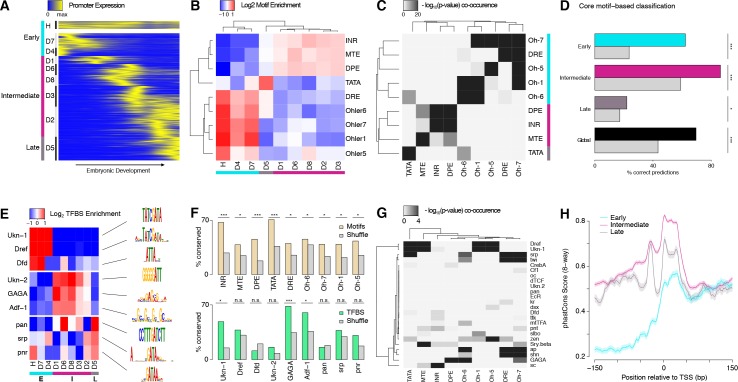
Core promoter structure defines three broad phases of embryonic development.(A) Clustering of expression profiles for 3462 promoters (maximum expression ≥10 RPM) defined as housekeeping (H, n = 240) or developmentally regulated (D, n = 3,222). Developmentally regulated promoters are divided into eight groups based on hierarchical clustering of expression profiles (see Materials and methods). Core promoter structure defines three broad developmental phases (color sidebar). (B) Relative enrichment of core promoter motifs in each expression cluster. Three major clusters can be defined (bottom color bar), which correspond to 3 phases of embryonic development (see (A); Early: 817 TSCs; Intermediate: 2,047; Late: 598). (C) Clustering of core promoter motifs based on their co-occurrence in the same promoters. This approach yields the same three major sets of motifs previously defined based on expression profiles (see (B)). (D) Predictions of expression timing from core promoter structure. Quadratic discriminant analysis on log-transformed motif scores was used to predict the developmental phase in which promoters are expressed. The performance of the classifier in leave-one-out cross-validation (color bars) is compared to random expectation (grey bars; FDR-corrected chi-square tests applied to individual contingency tables as appropriate). (E) Distinct sets of TFBSs are enriched near the core promoters active in the three developmental phases. The top three motifs for each core promoter class are shown. (F) The conservation of core promoter motif composition between D. melanogaster and D. pseudoobscura confirms the biological relevance of the motifs. (Grey bars: conservation of shuffled motifs; FDR-corrected chi-square tests). (G) Many TFBSs are strongly associated with specific sets of core promoter motifs. Results are shown for the three motifs most enriched near the promoters of each expression cluster. (H) The three major core promoter classes display distinct profiles of sequence conservation. Lines: median phastCons scores across promoters of the class. Envelope: standard error in the estimate of the median, computed by bootstrapping.